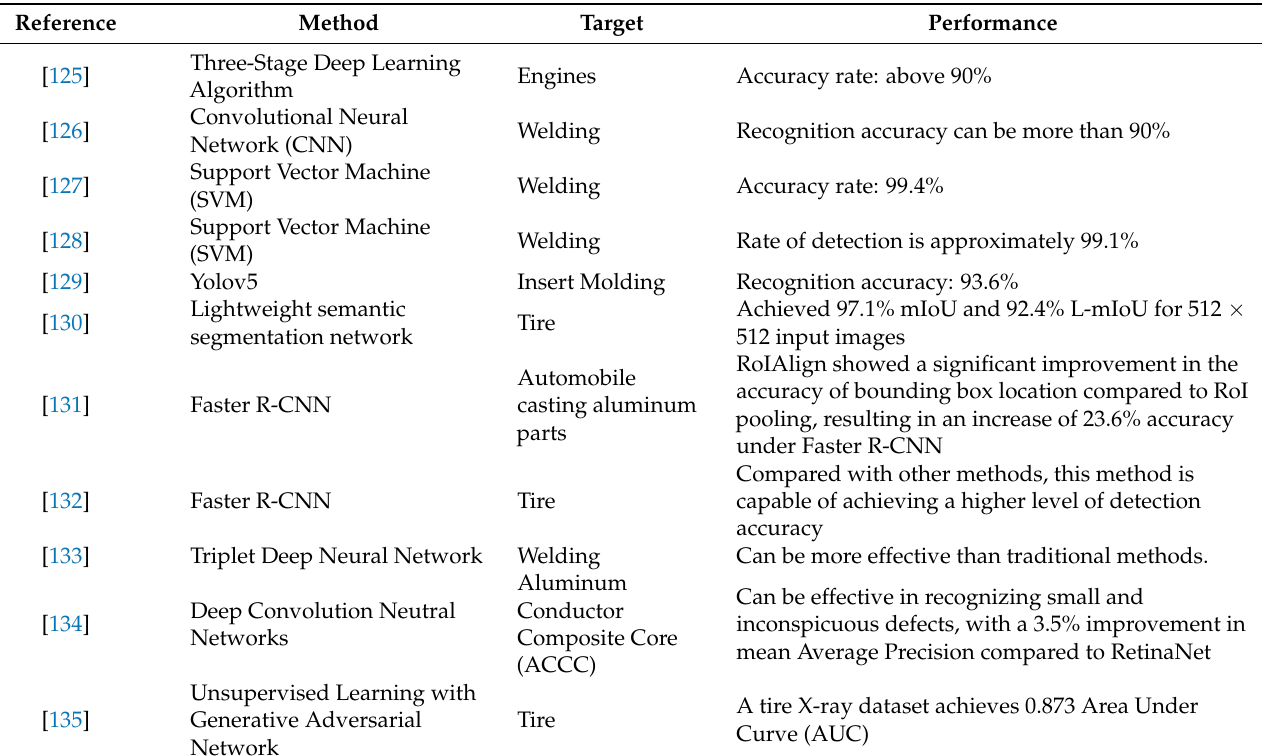
Table 6. Recent publications on deep learning defects detection in X-ray